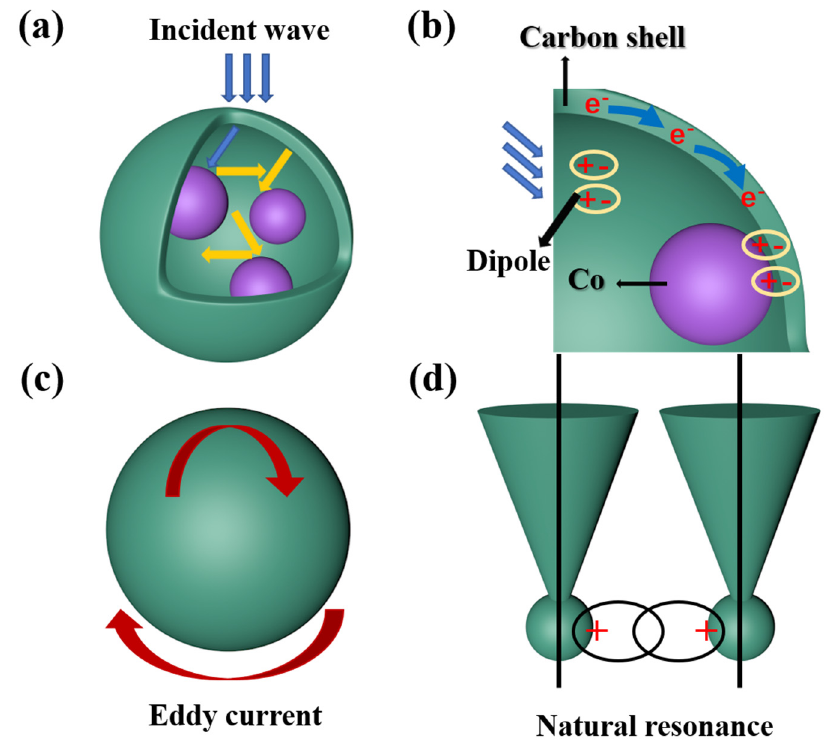
Figure 9. Schematic illustration of EM wave absorption mechanisms for Co@C nanospheres: ( a ) multiple reflection; ( b ) dielectric loss mechanisms; ( c ) eddy current; ( d ) natural resonance.